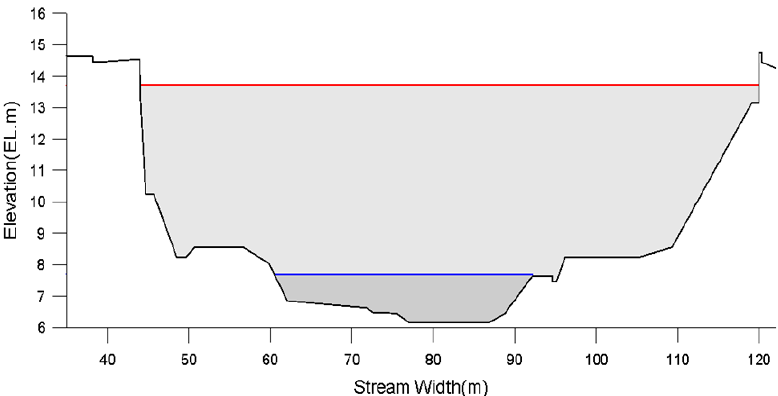
Figure 4. Threshold water levels of Dorim Stream at the warning points for issuing a flood warning (blue line) or an evacuation order (red line).